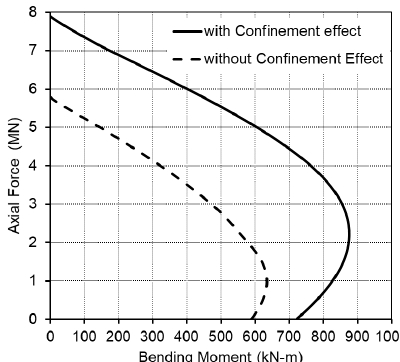
Figure 17. P–M interaction curves of designed specimen from CoWiTA.